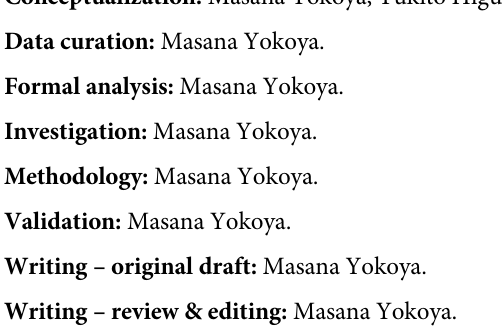
S1 Fig. Map of the 47 prefectures of Japan. The numbers correspond to the prefecture infor- mation presented in S1–S3 Tables. S1 Table. Standardized height of 5- to 17-year-old children and adolescents in each prefec- ture of Japan averaged over a 25-year period (1989–2013). S2 Table. Standardized weight of 5- to 17-year-old children and adolescents in each prefec- ture of Japan averaged over a 25-year period (1989–2013). S3 Table. Basic association between standardized heights and weights for each age group. S4 Table. Population-weighted effective day length derived from Mesh Climatic Data 2000 for each prefecture of